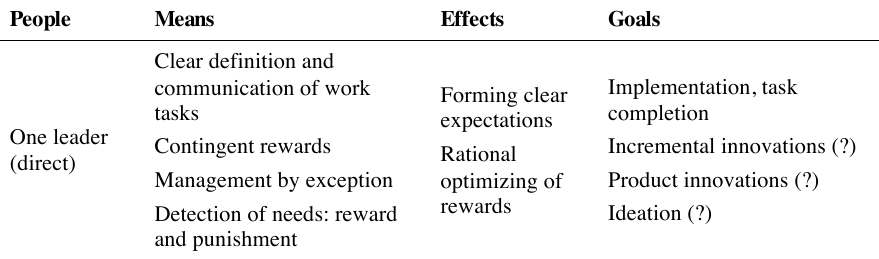
Table 6. Profile of existing research on transactional/instrumental leadership (LS5). People Means Effects Goals Clear definition and communication of One leader